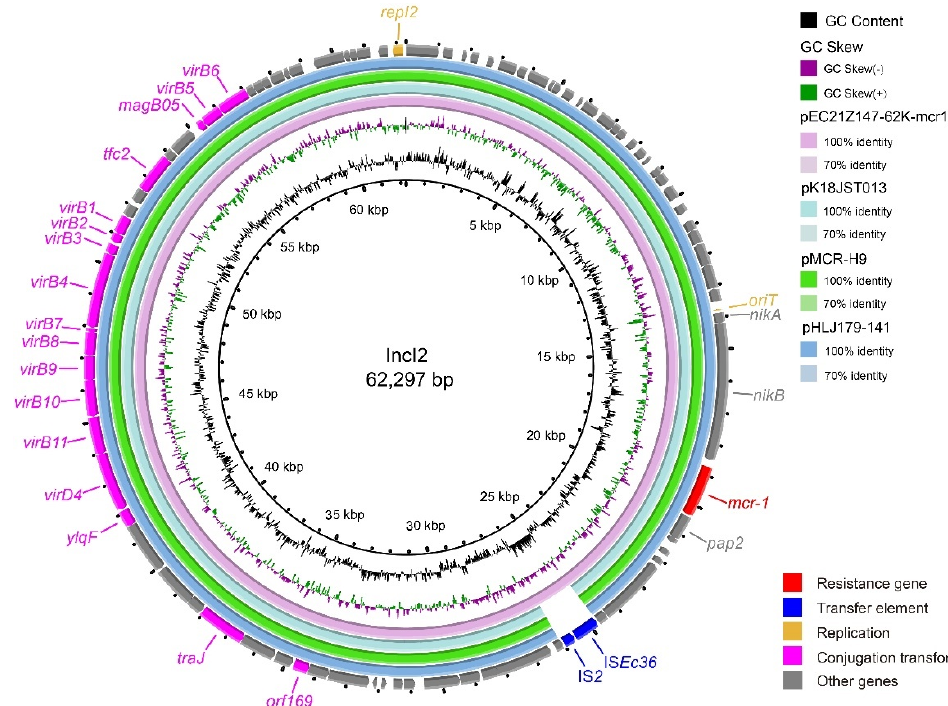
Figure 7. Genetic characteristics of the bla NDM-5 -positive plasmid pEC21Z063-110K-NDM5 identified in this study compared with similar plasmids from pathogenic bacteria in humans or animals. The arrows and triangles represent genes from different functional categories (red: ARGs, dark blue: insertion sequence, orange: replication, pink: conjugation transfer, grey: other genes).